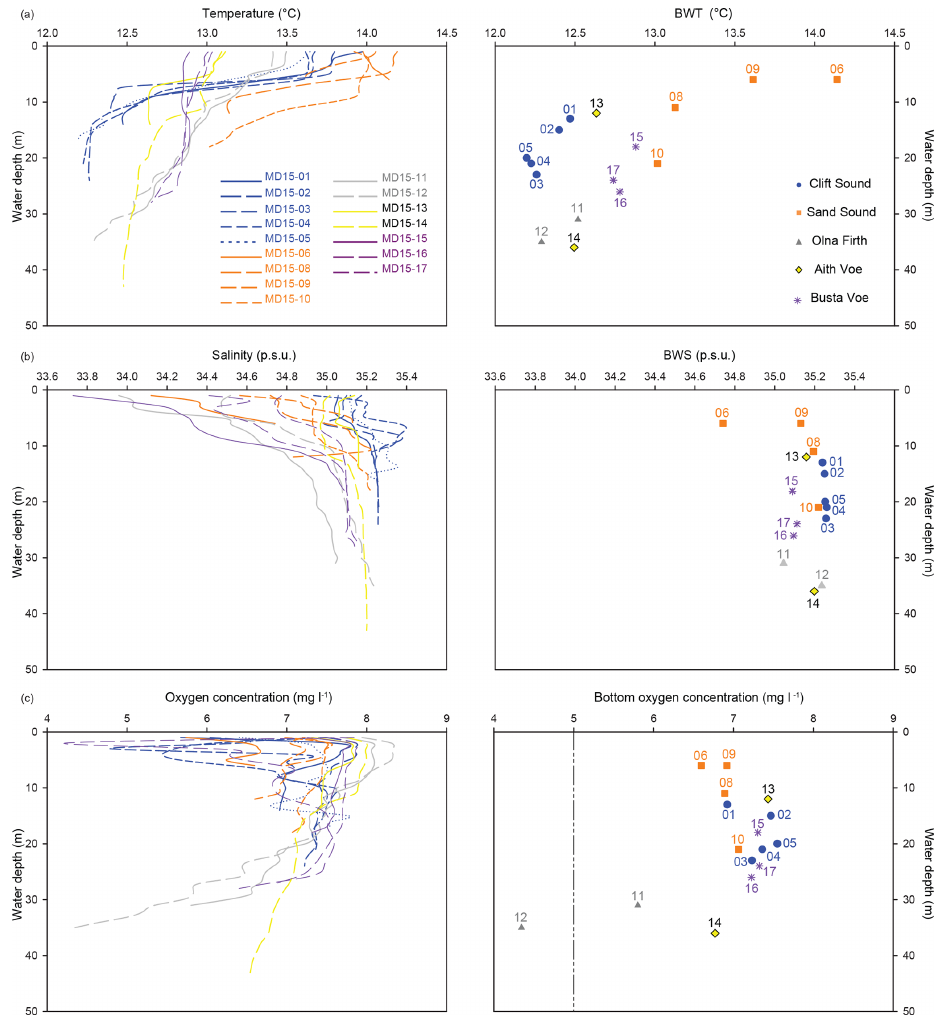
Figure 2. CTD profiles from the 2009 survey. (a) Temperature profiles and bottom water temperature (BWT) at each sampling station. (b) Salinity profiles and bottom water salinity (BWS) at each sampling station. (c) Dissolved oxygen profiles and oxygen concentration in bottom waters at each sampling station. The dashed line at 5mgL − 1 indicates the possible onset of hypoxic